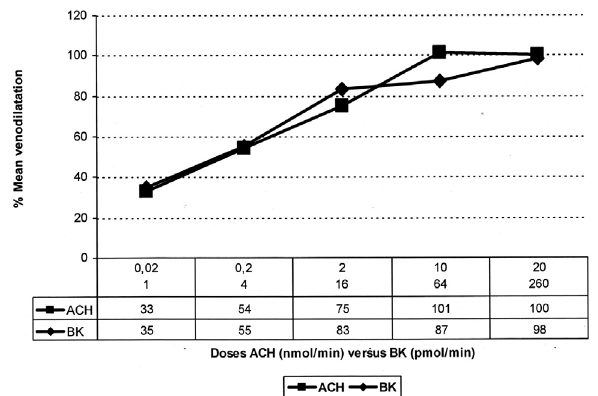
Figure 2 - Relationship between venodilation responses (% mean venodila- tion) for each dose of acetylcholine (ACH) or bradykinin (BK)